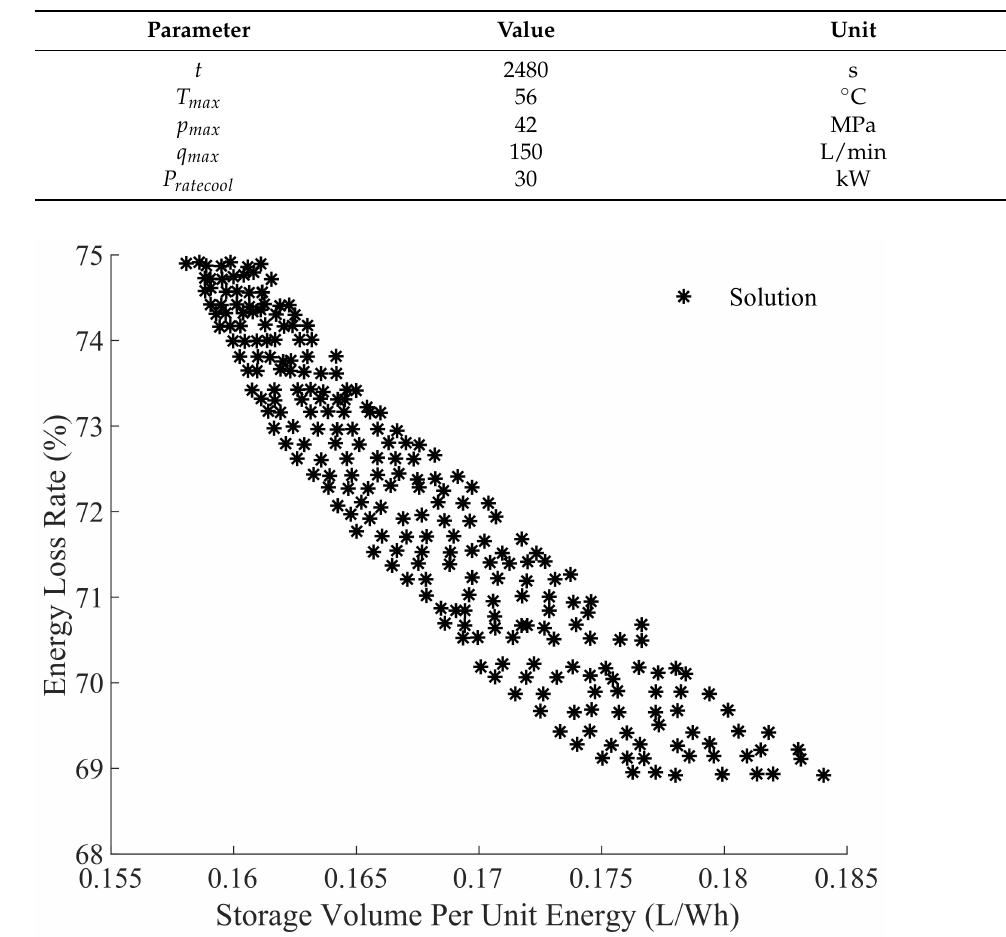
Figure 17. Scheme results of